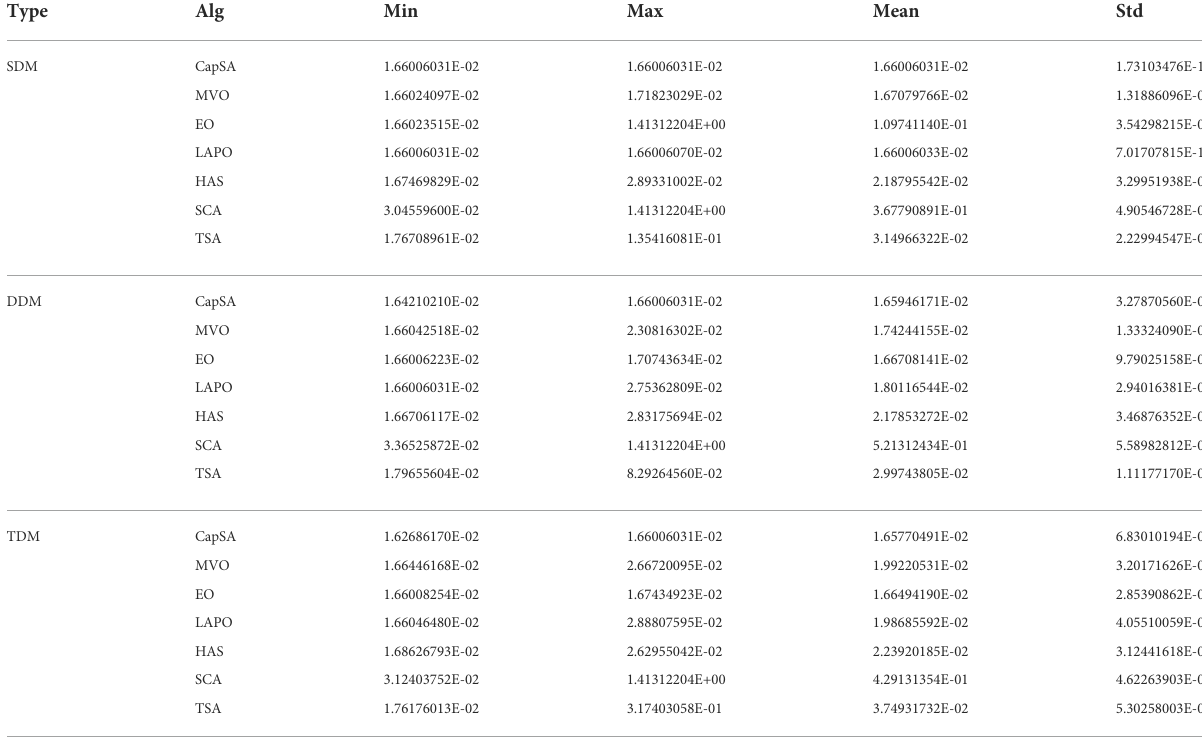
TABLE 9 Statistical parameters of the approaches applied to the STP6-120/36 panel.